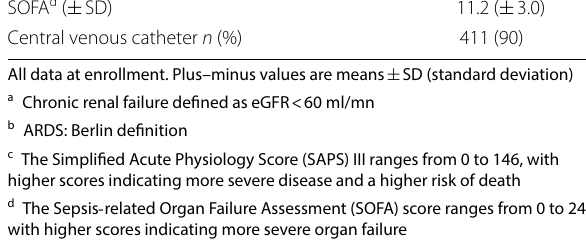
SD (standard deviation) ±